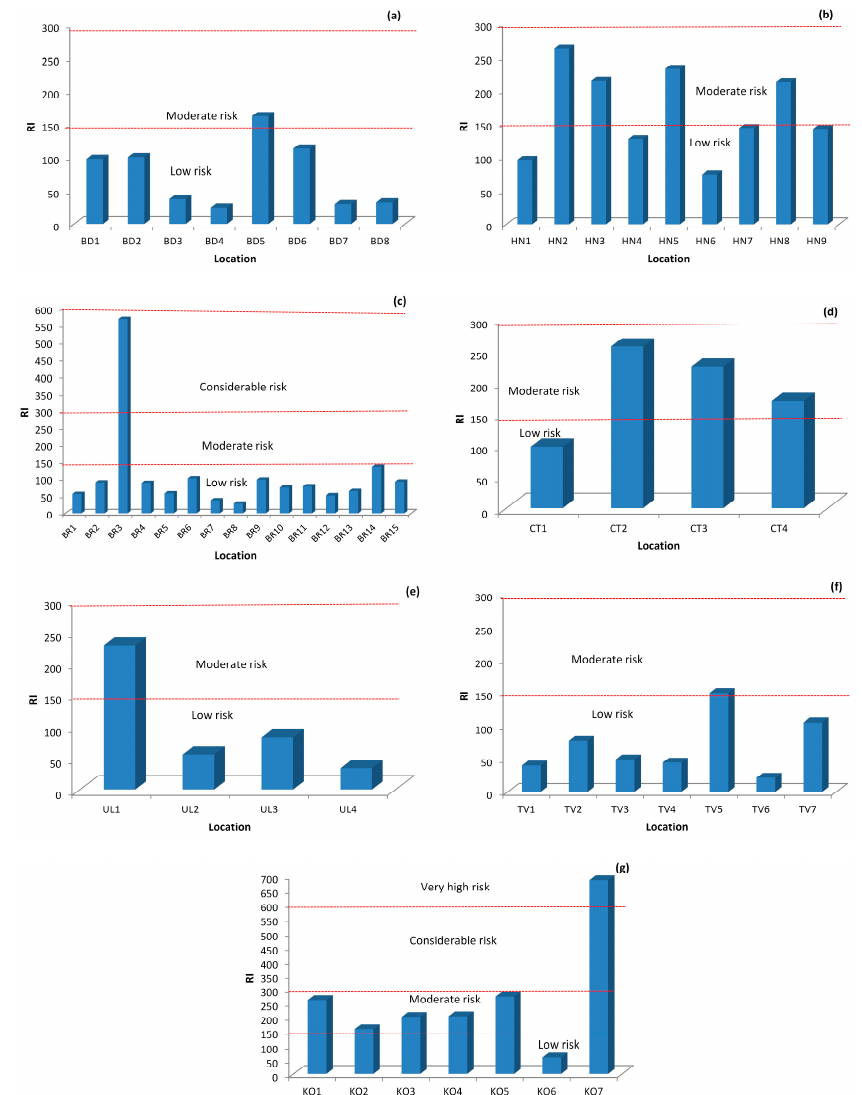
Figure 2. Ecological risk index (RI) values of heavy metals in urban parks soil samples in coastal municipalities of Montenegro, ( a ) Budva; ( b ) Herceg Novi; ( c ) Bar; ( d ) Cetinje; ( e ) Ulcinj; ( f ) Tivat; ( g ) Kotor.